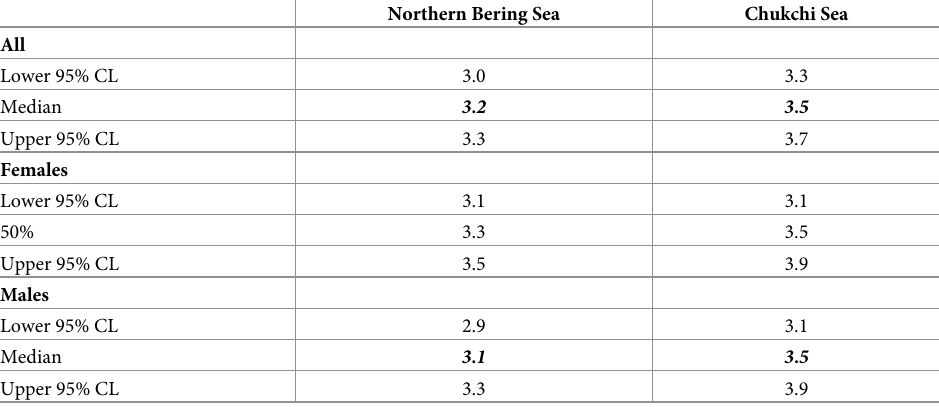
Table 2. Trophic position (TP) estimates for Pacific walruses by region and sex. TP estimates are shown as the median with 95% confidence levels (CL). Regions included the northern Bering Sea (NBS) and Chukchi Sea. The values shown in bold and italicized were significantly different ( p < 0.05).